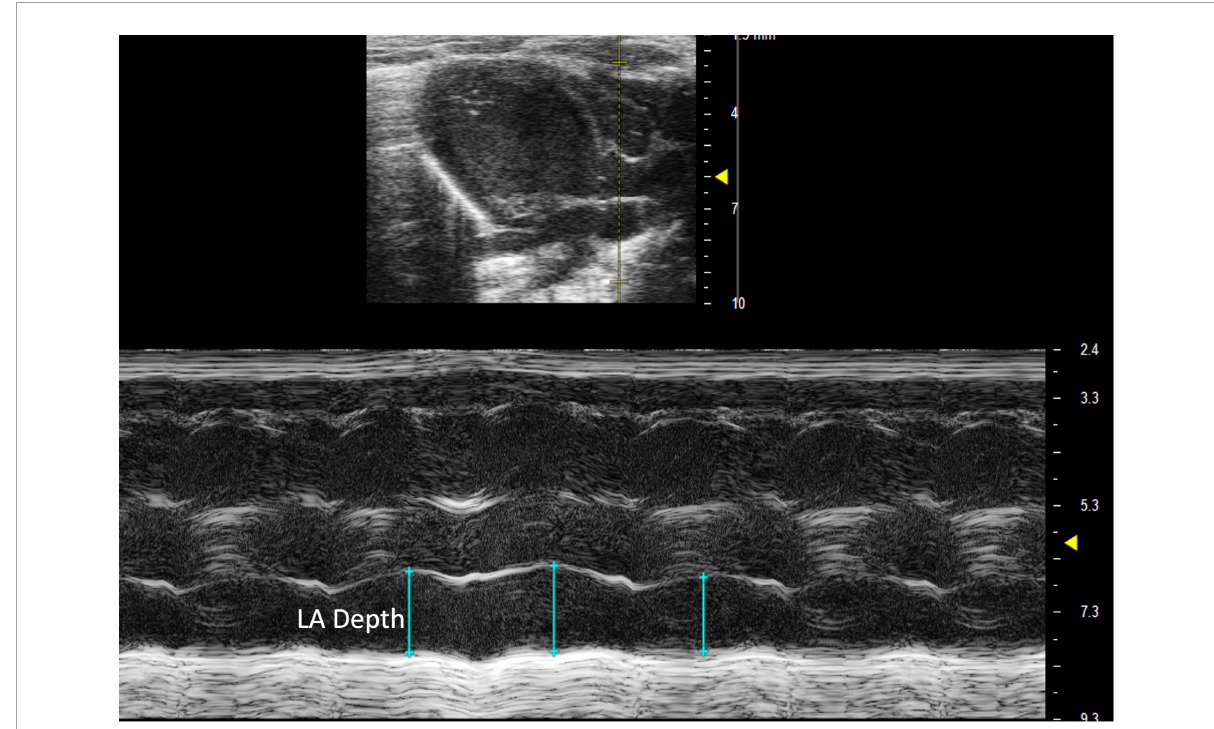
FIGURE8 Parasternal long axis (PLAX) M-mode view displaying left atrial depth measurement just inferior to the aorta.